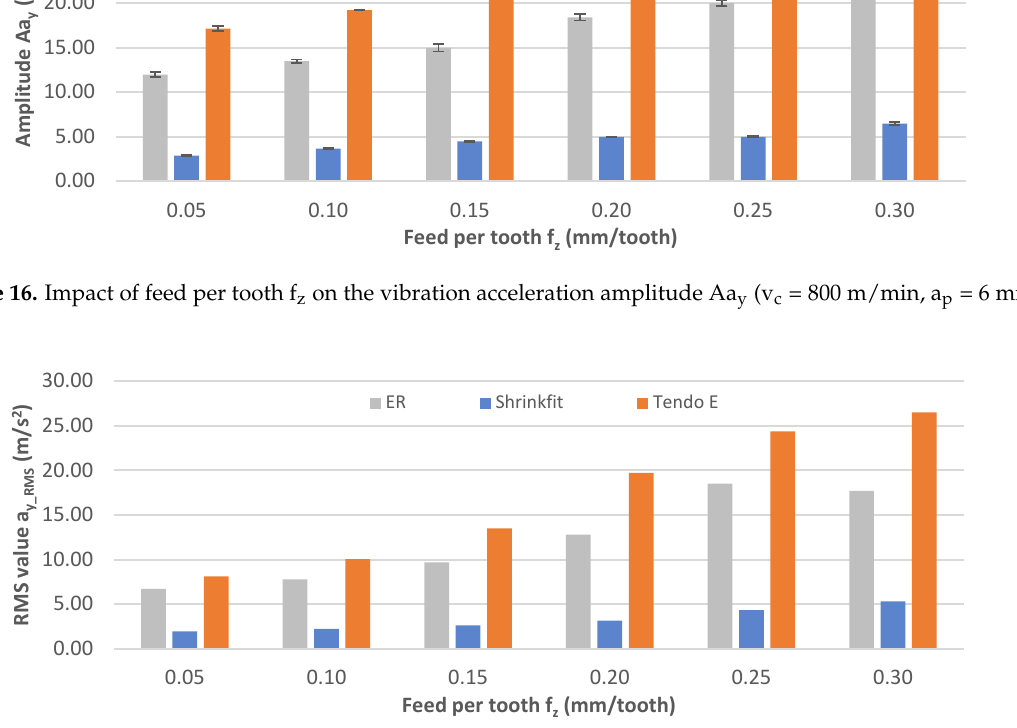
Figure 16. Impact of feed per tooth f z on the vibration acceleration amplitude Aa y (v c = 800 m/min, a p = 6 mm).